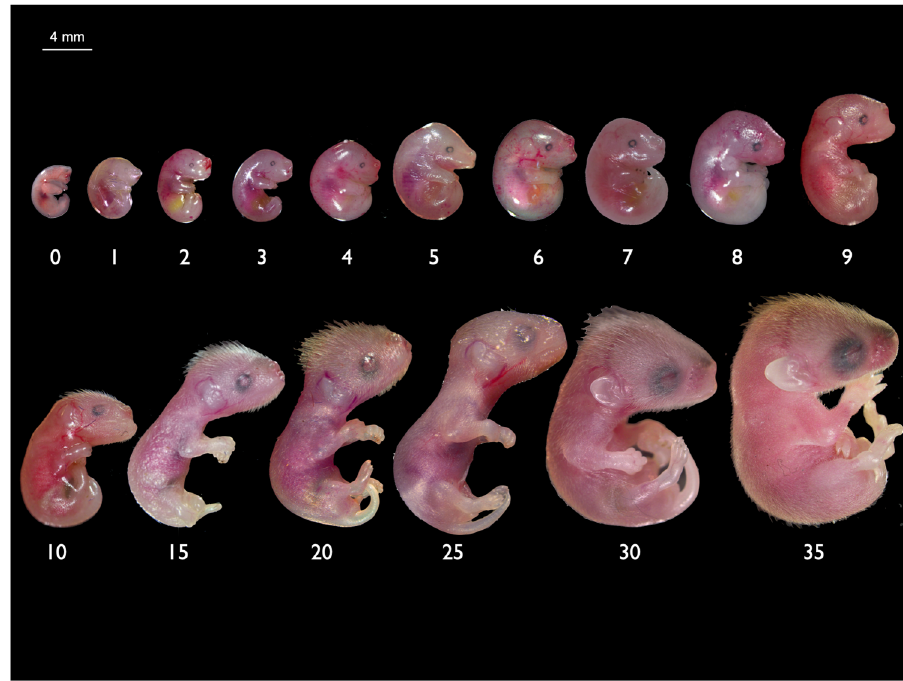
Fig. 2 Gross morphology of the fat-tailed dunnart throughout postnatal development in the pouch. Numbers below pouch young refer to the day